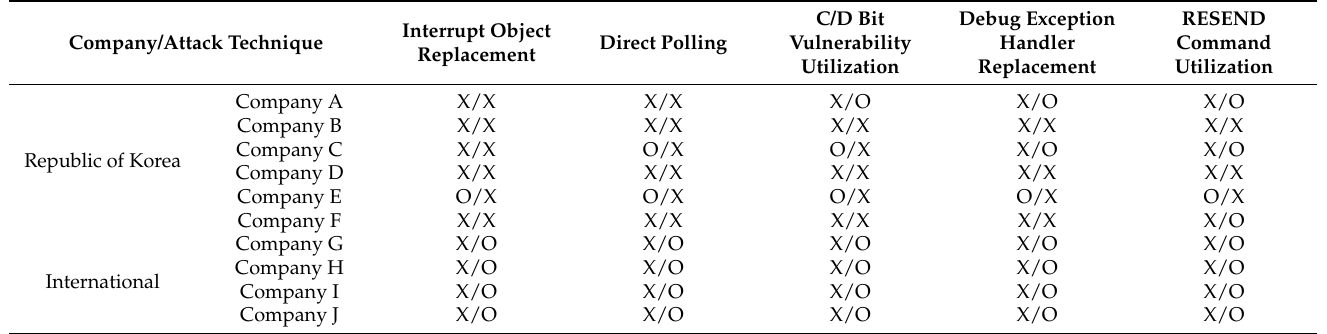
Table 5. Scan code exposure and detection of the sample attack program